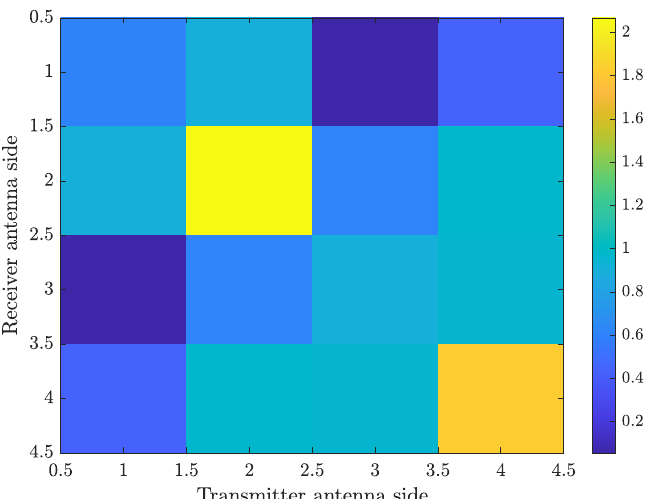
Figure 3. The expectation E { HH H } , where H ∈ C N T × N R is the channel matrix of a subcarrier. Here, N T = N R = 4 and f d = 200